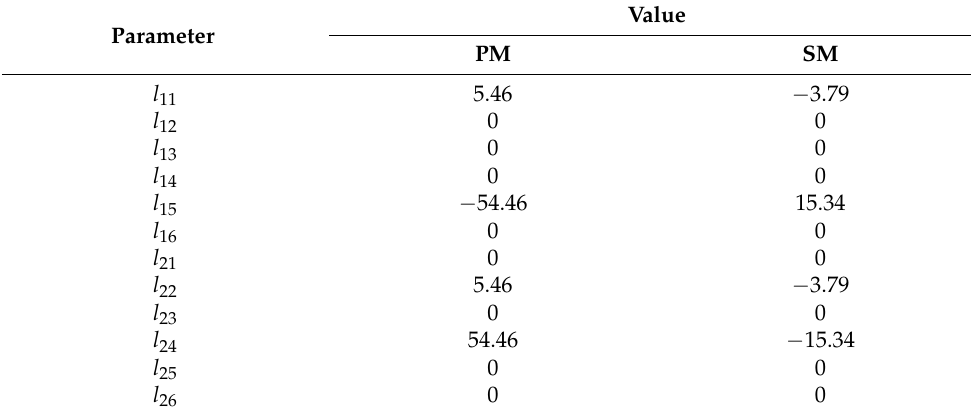
Table 2. The optical sensitivity coefficients.